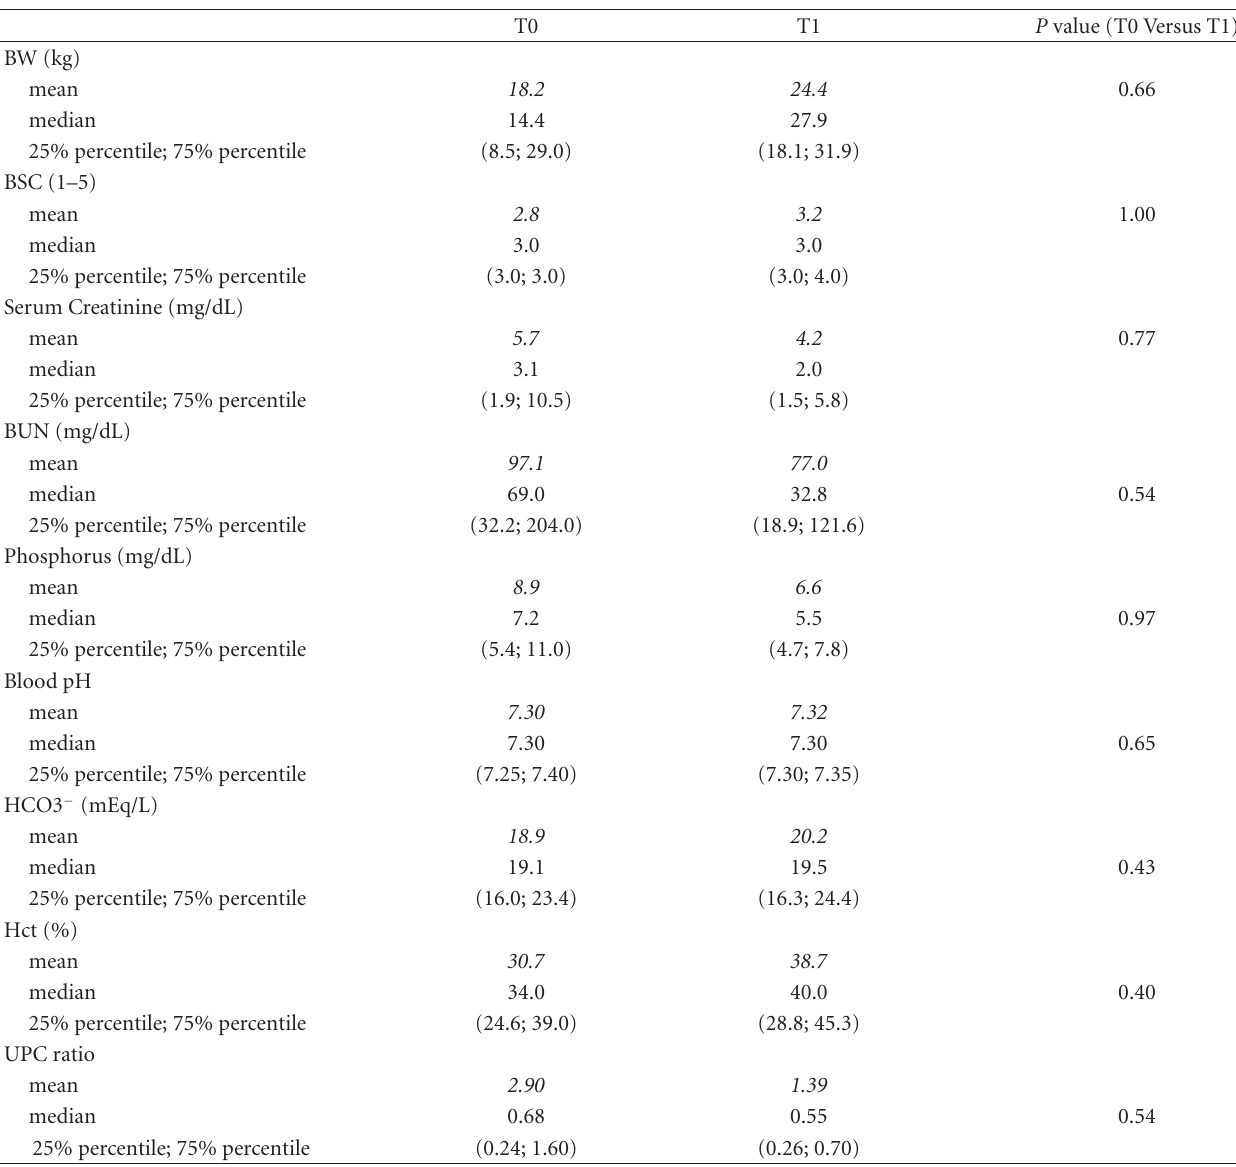
Table 4: Mean, median, 25% and 75% percentile for BW and BCS, hematocrit, serum creatinine, BUN, phosphate, blood pH, bicarbonate, and UPC ratio, for group A at time of randomization (T0) and after 4–8 weeks (T1) of treatment. Di ff erence between values at di ff erent examinations are depicted by P -value (statistically significant P < 0 .